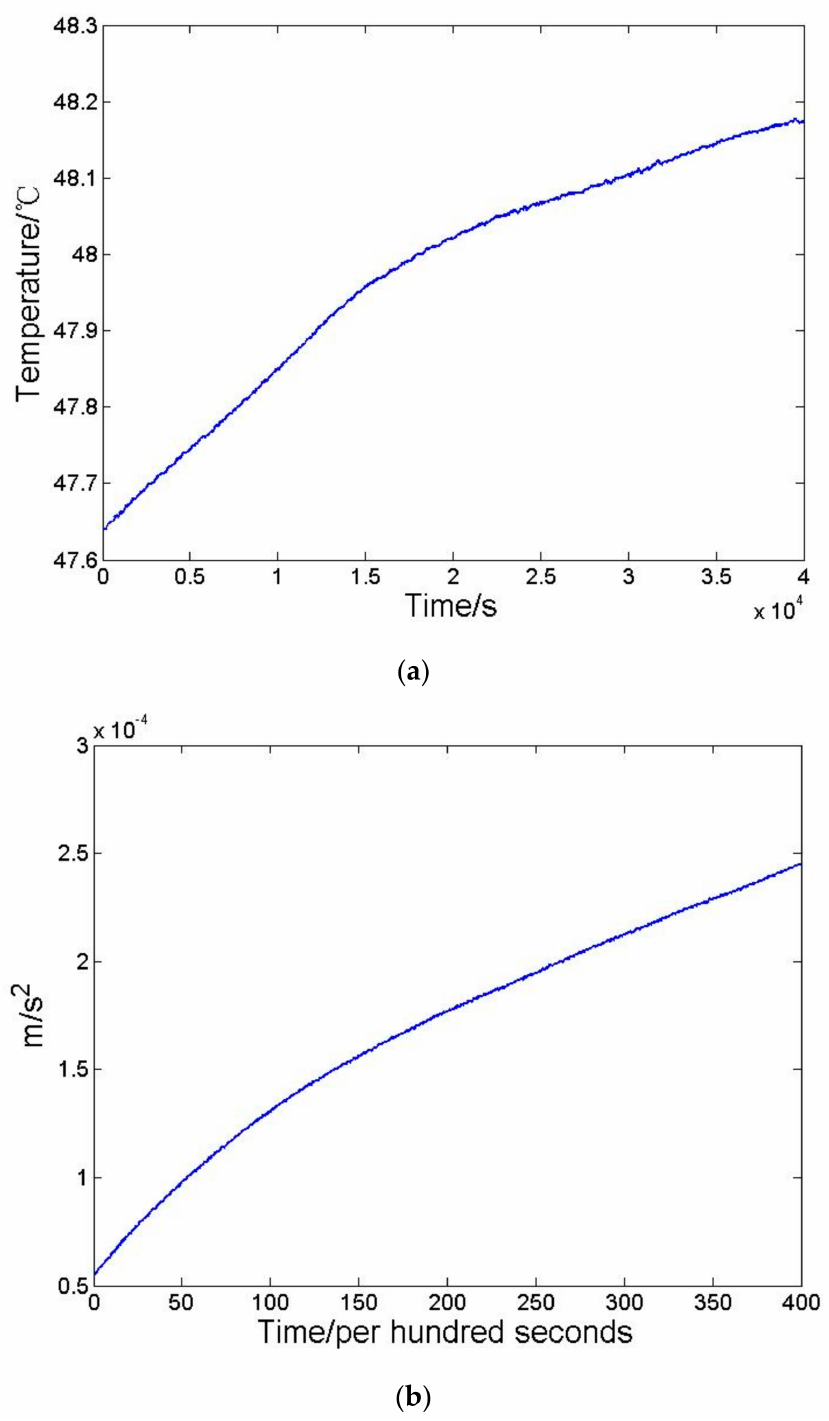
Figure 2. ( a ) The temperature variation of the accelerometer, and ( b ) the mean value per hundred seconds of accelerometer